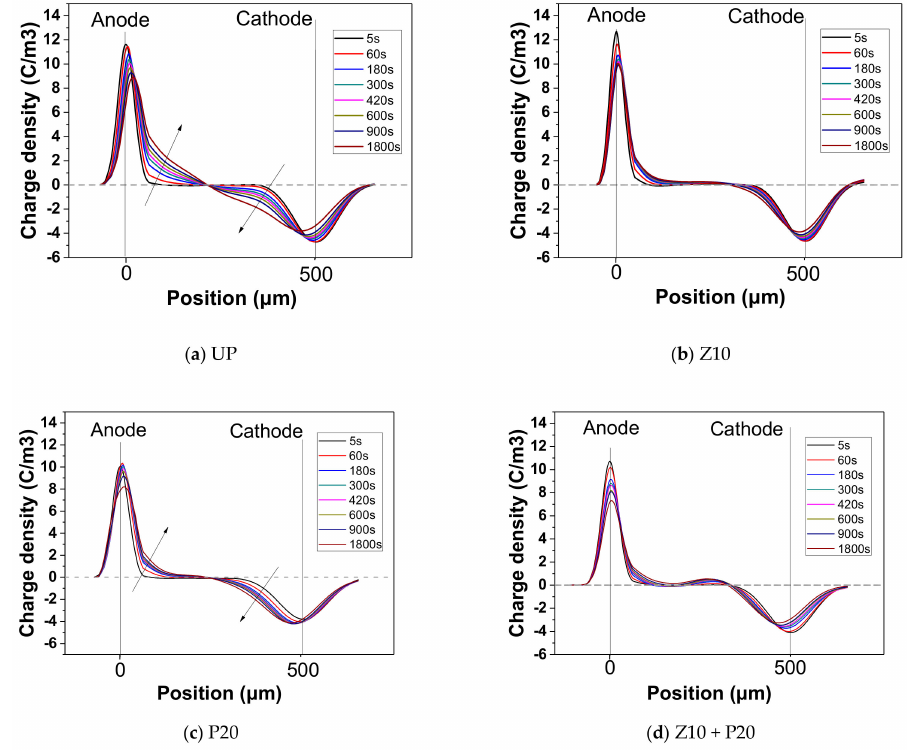
Figure 10. The space charge behavior of ( a ) UP, ( b ) Z10, ( c ) P20, and ( d ) SP under DC 15kV /